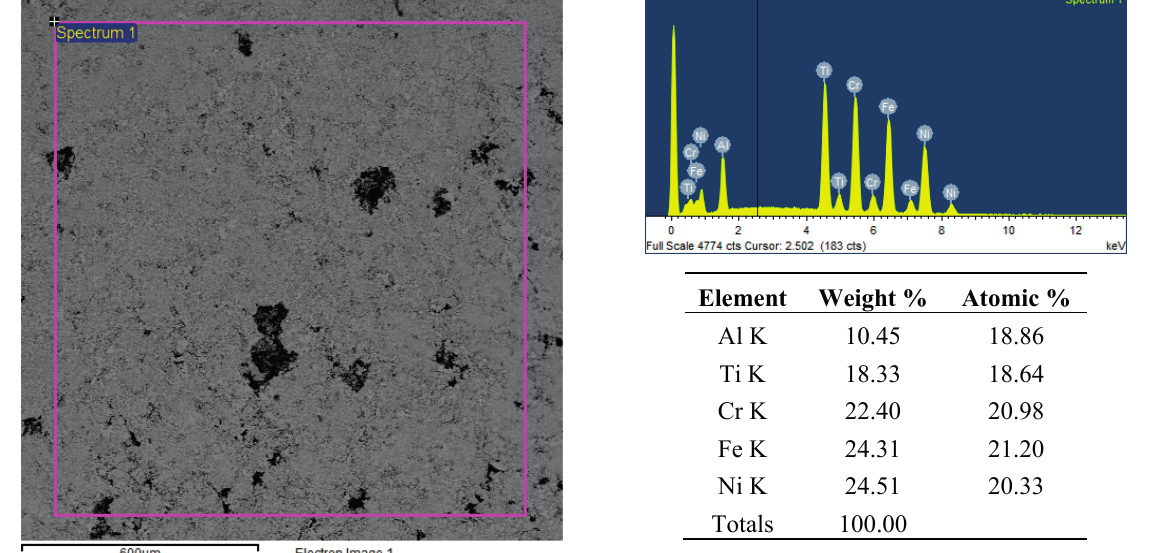
Figure 8. Backscattered electron SEM micrographs, EDS spectra and elemental analysis of the FeCrNiTiAl sample’s surface after microwave heating at 700 W, 2450 MHz, in regions of the predominant electric field of the applicator (forming pressure = 300 MPa).